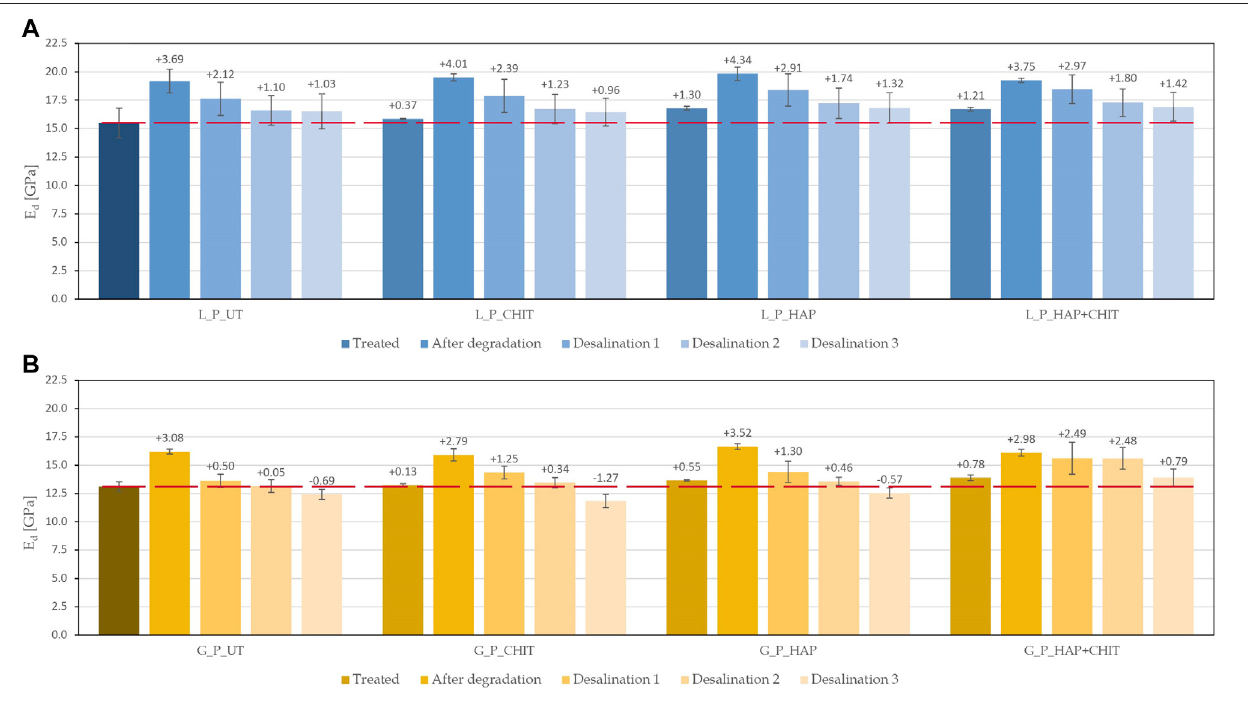
FIGURE 13 | Dynamic elastic modulus of the prismatic samples at each stage of the research (the dotted line indicates the initial value of the UT reference), for: (A) Lecce stone and (B) Globigerina limestone. The dotted line indicates the initial value of the UT reference (15.49 GPa for L and 13.11 GPa for G).